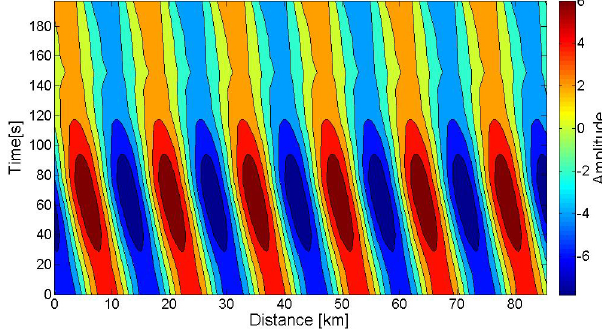
Figure 4. Hovmöller diagrams of the reconstructed wave structure along the propagation direction for consecutive time